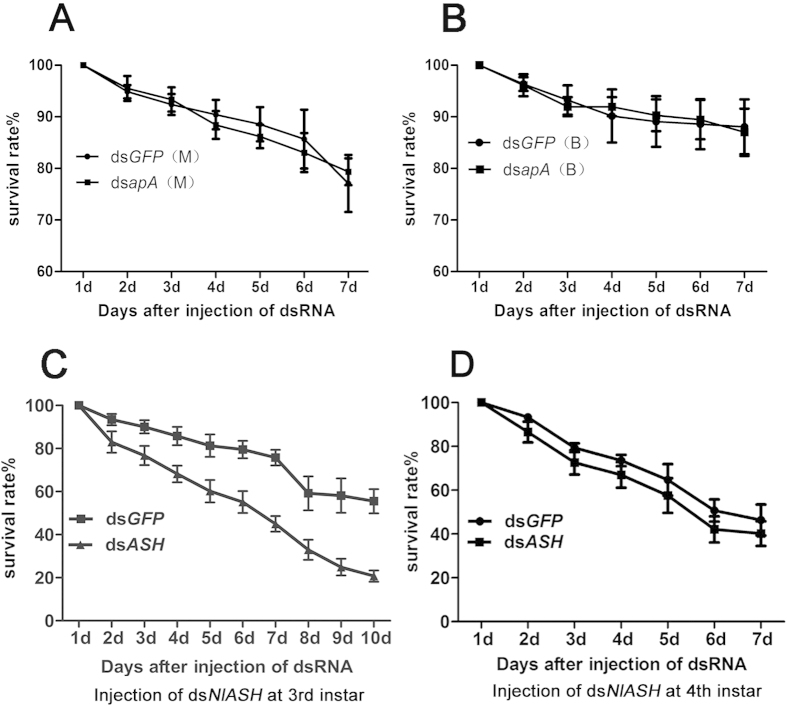
Survival response of N. lugens to dsNlapA and dsNlASH injection at 3rd-instar or 4th-instar.(A) Survival response of BPHs of MS to dsNlapA injection at 3rd-instar; (B) Survival response of BPHs of BS to dsNlapA injection at 3rd-instar; (C) Survival response of BPHs to dsNlASH injection at 3rd-instar; (D) Survival response of BPHs to dsNlASH injection at 4th-instar. dsGFP injection was served as negative control. Each n = 3 groups of 45 nymphs. Survival responses to the dsGFP and dsNlASH were analyzed using Repeated Measure ANOVA: (A).F1,4 = 0.015; P = 0.908; (B). F1,4 = 0.002; P = 0.965; (C). F1,4 = 16.164; P = 0.016; (D). F1,4 = 1.021; P = 0.369. M: macropterous strain; B: brachypterous strain.